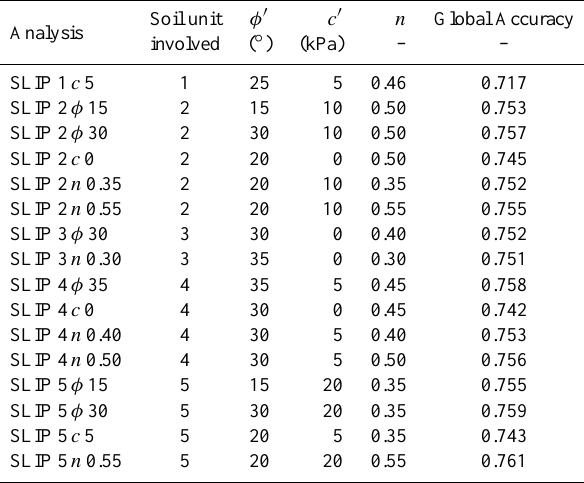
Table 4. Values of input parameters A and λ for the SLIP sensitivity